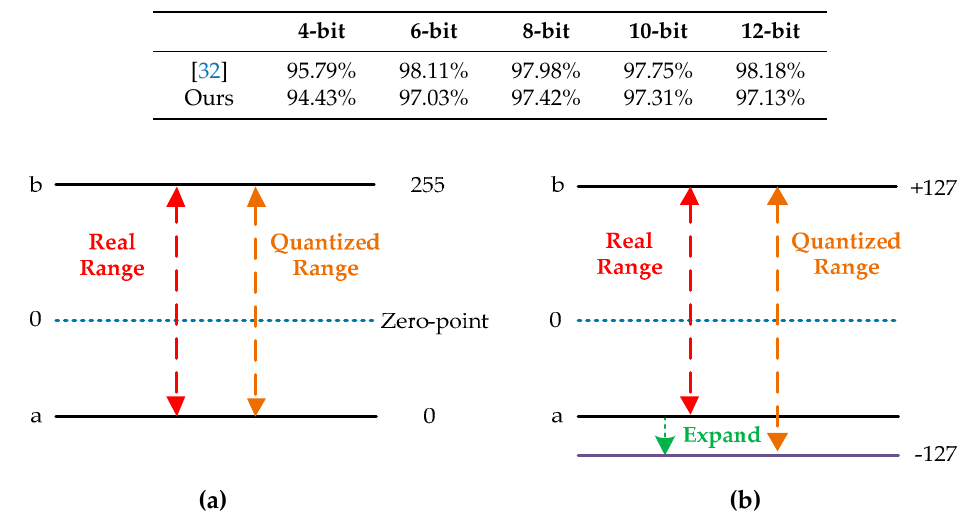
Table 7. Classification accuracies under the proposed scheme and the scheme in [32] .